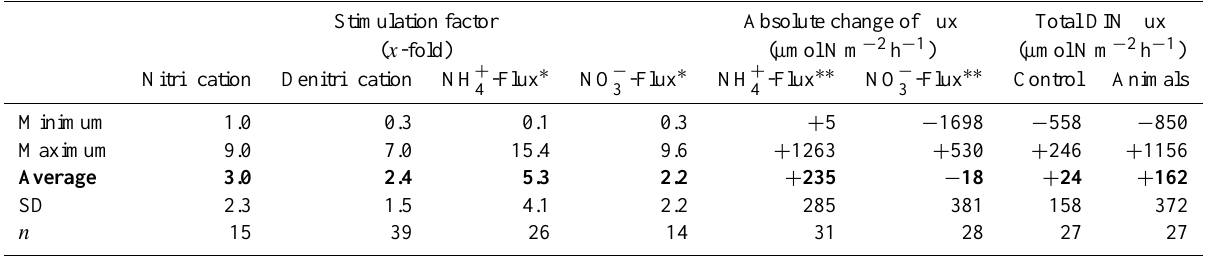
Table 1. Macrofauna-induced stimulation of benthic nitrification and denitrification and of ammonium and nitrate fluxes across the sediment– water